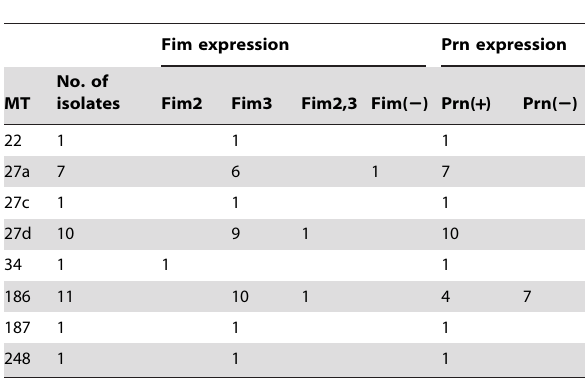
Table 2. Relationship between MTs and phenotypes in Bordetella pertussis isolates collected during the 2008 2 2010 pertussis epidemic